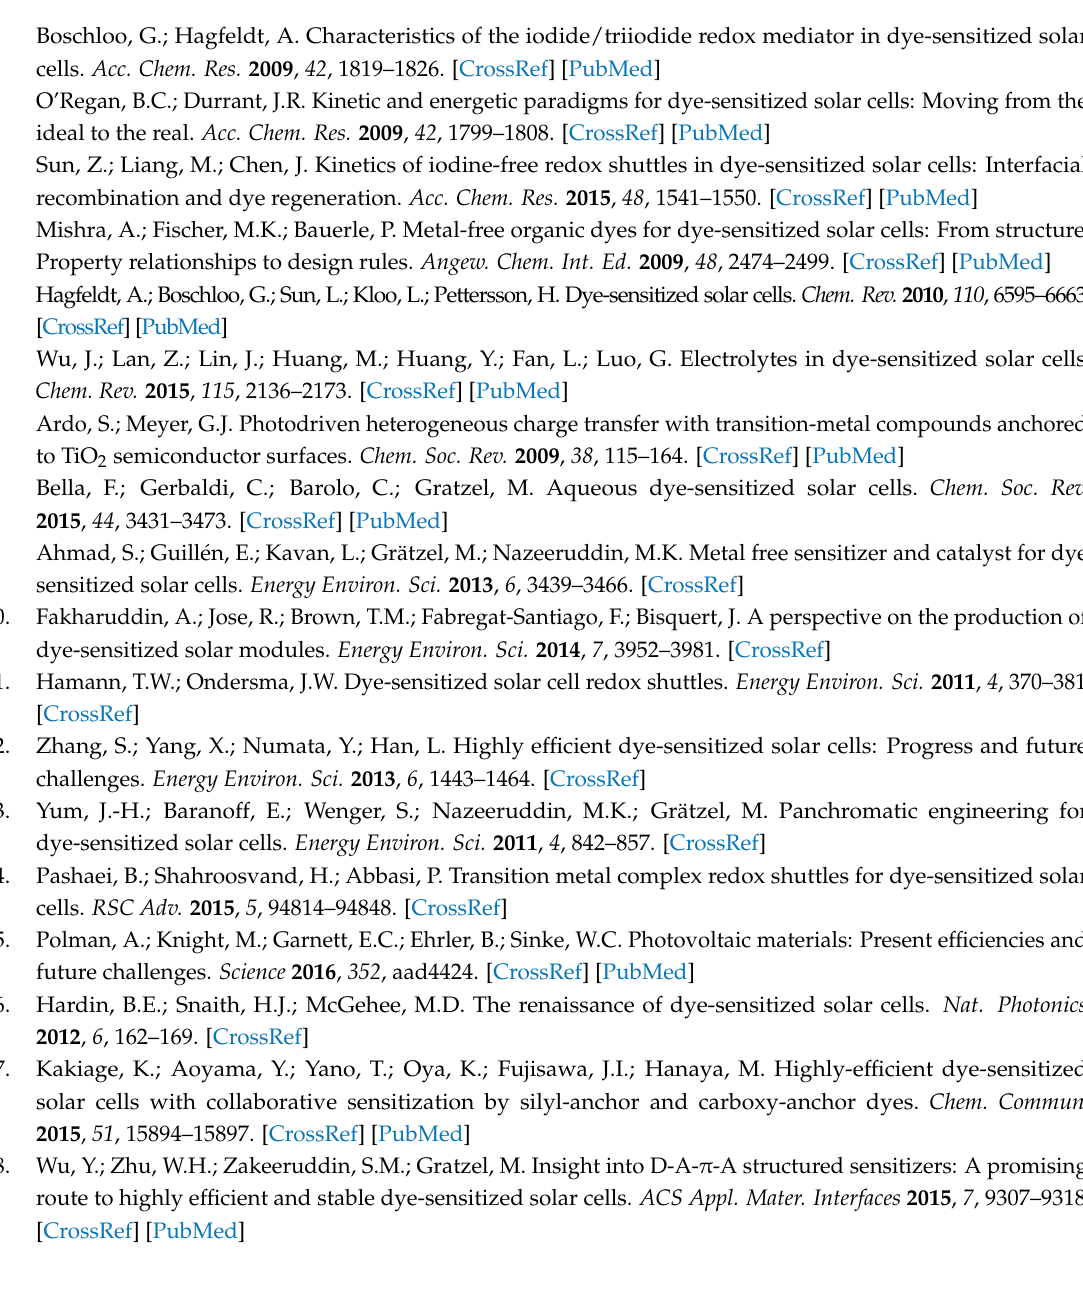
Figure S6. 13 C NMR spectrum of compound 6 (CDCl 3 , 125 MHz); Figure S7. 1 H NMR spectrum of compound 7 (CDCl 3 , 300 MHz); Figure S8. 1 H NMR spectrum of compound 9 (CDCl 3 , 300 MHz); Figure S9. 13 C NMR spectrum of compound 9 (CDCl 3 , 75 MHz); Figure S10. 1 H NMR spectrum of compound AP12 (DMSO- d 6, 500 MHz, 80 o C); and DFT cartesian coordinates for the AP series